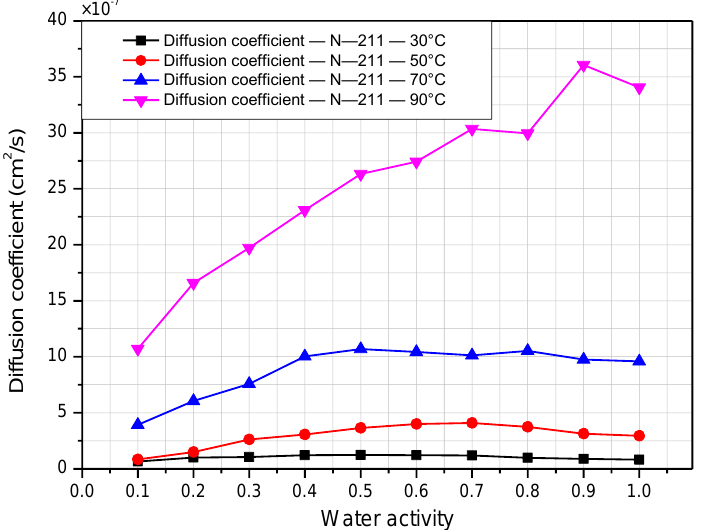
Figure 11. Diffusion coefficient of Nafion 211 membrane according to relative humidity at operating temperatures from 30 °C to 90 °C.